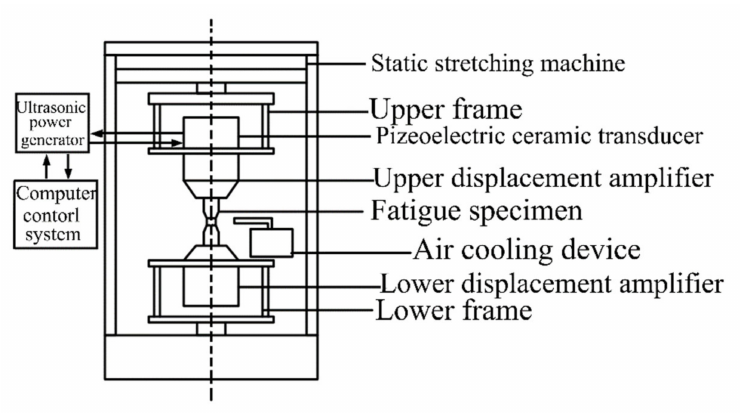
Figure 4. The schematic diagram of asymmetric ultrasonic fatigue.